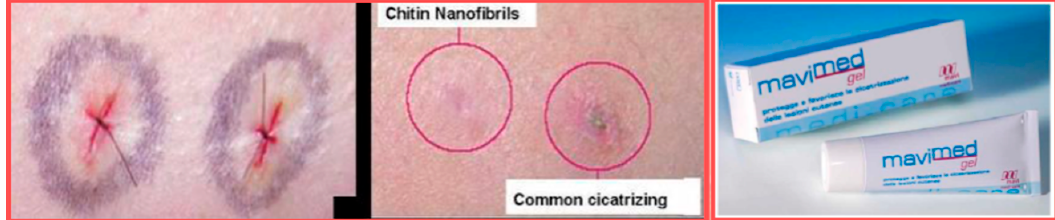
Figure 17. Skin barrier repairing activity of chitin nanofibrils [56].